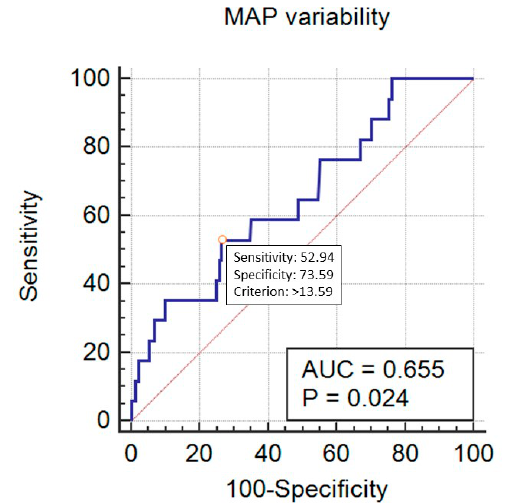
Figure 7. Prediction of mortality by the mean blood pressure (MAP) variability (expressed as MAP_Cv in %).